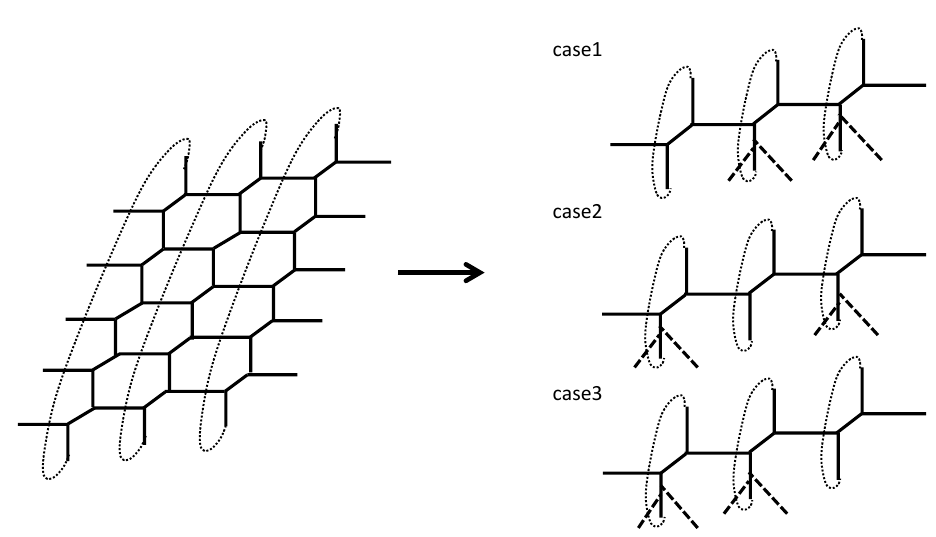
Figure 10 . The geometric transition which emerge the two defect branes. The summation of them corresponds to the qq -character of (cid:22) 3